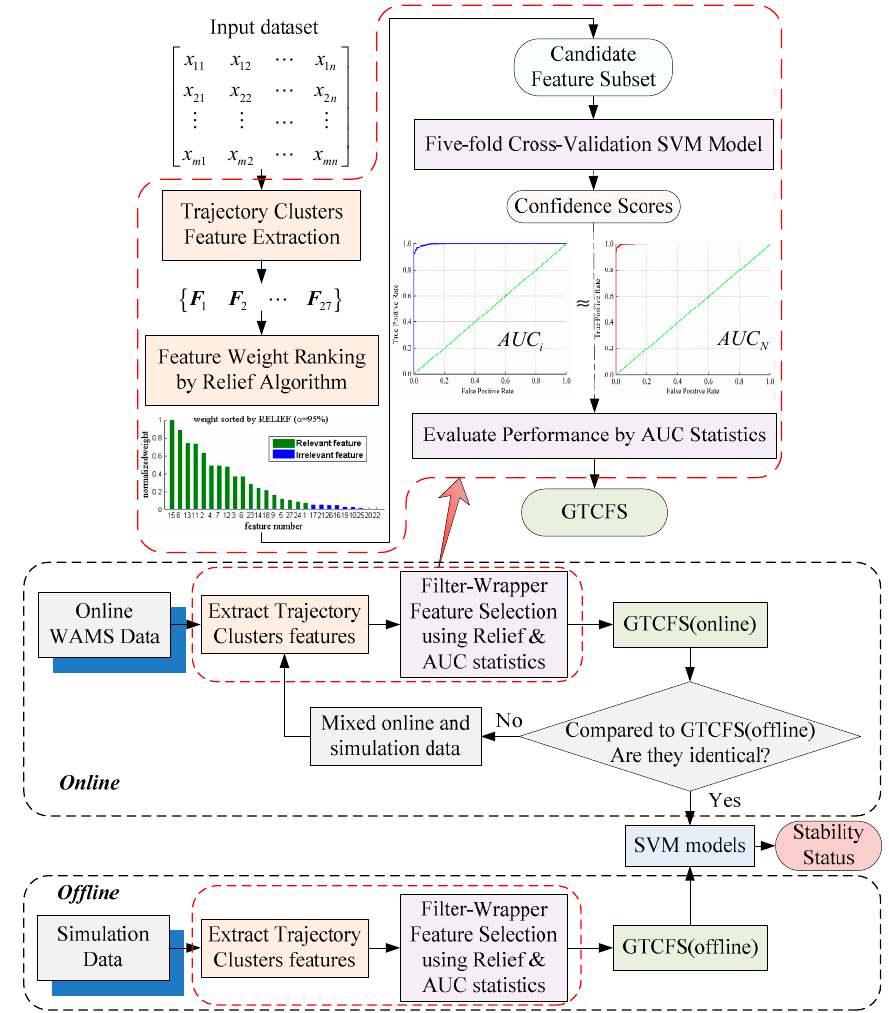
Figure 3. Transient stability prediction algorithm flowchart based on trajectory cluster features.